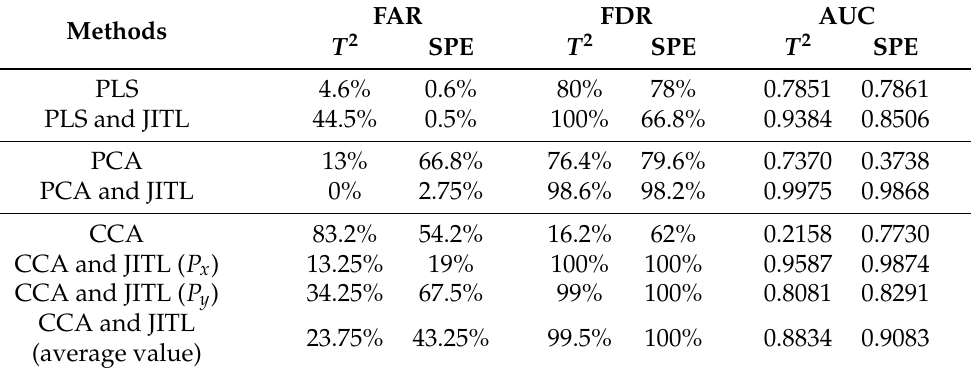
Table 2. Independent testing of FD